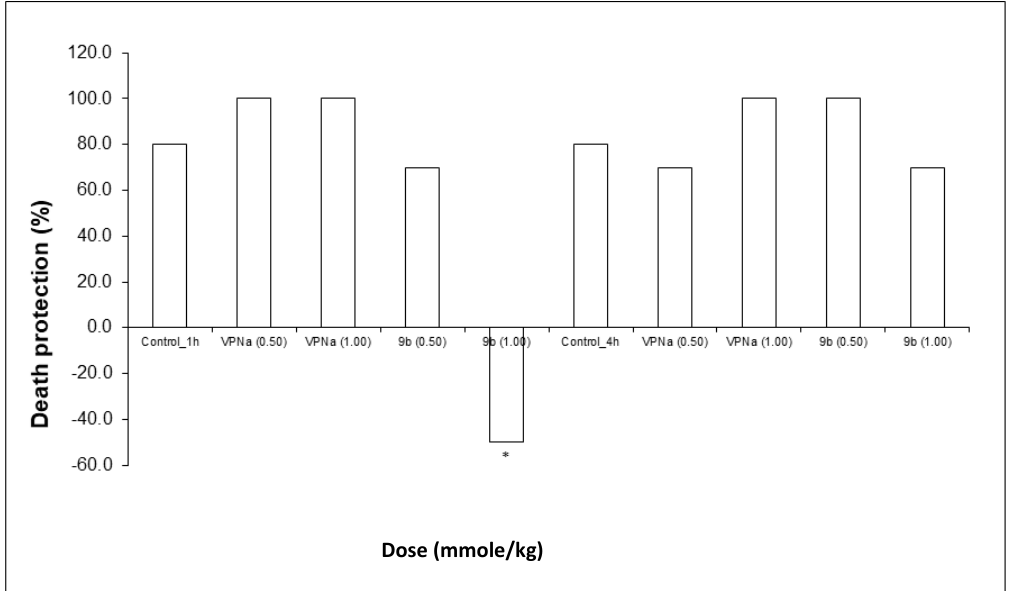
Figure 7. Percentage of death protection of compound 9b compared to VPNa at different doses (0.50 and 1.00 mmole/kg) at 1 h and 4 h of pretreatment. * p < 0.05: Significant difference comparing control group with 9b and VPNa as positive control group. Comparisons were made by the Fisher Exact test.